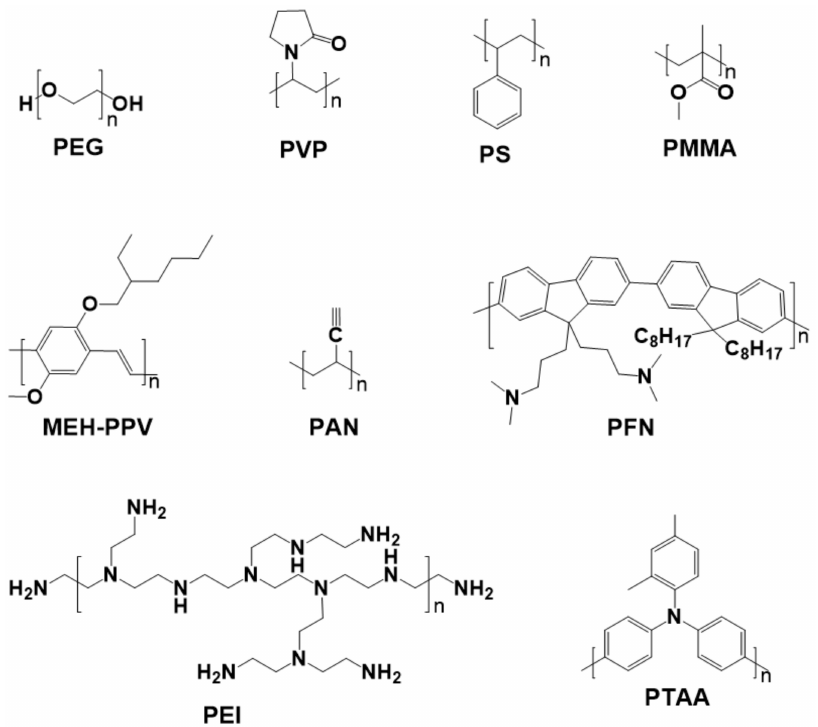
Figure 9. Molecular structures of common polymer